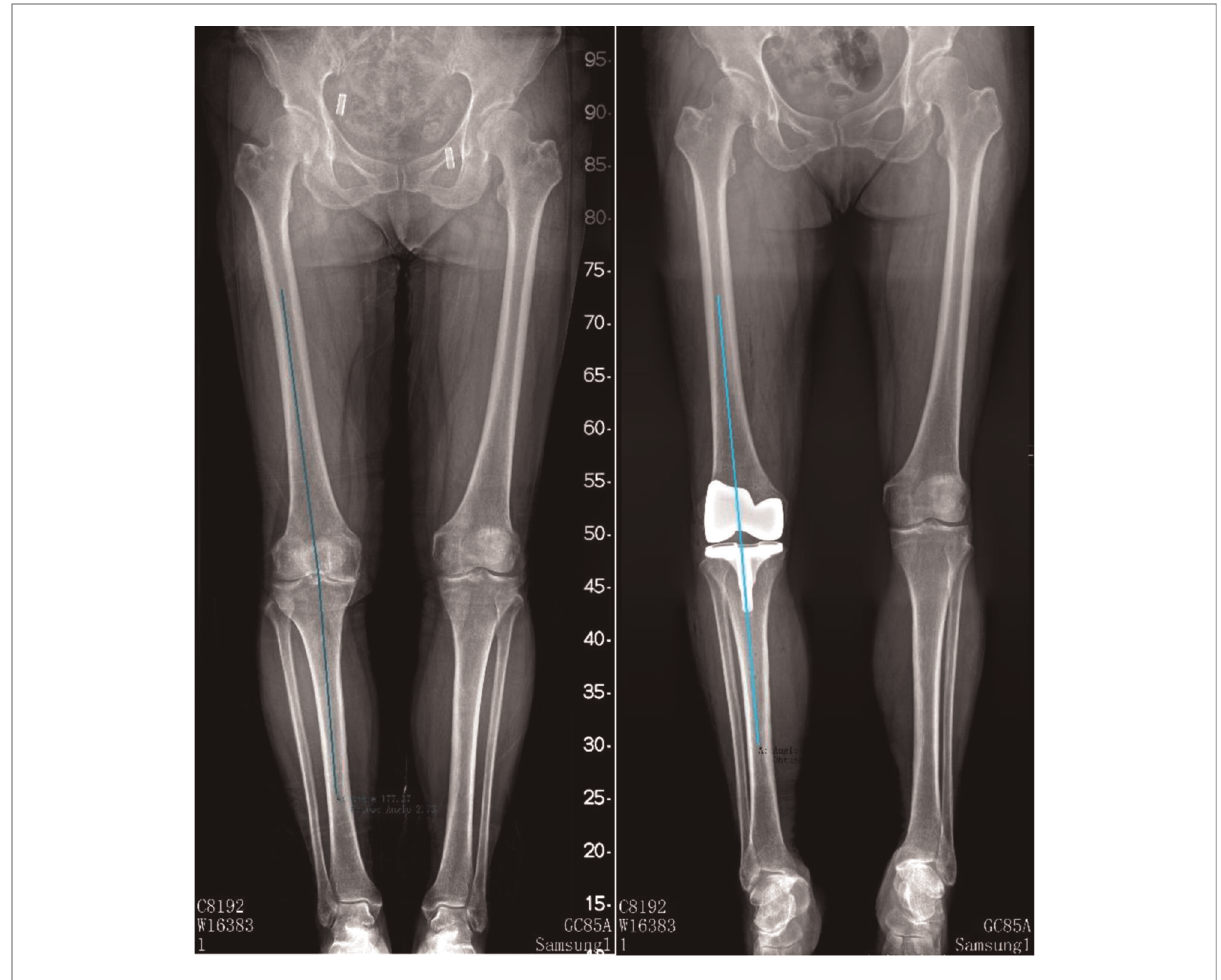
FIGURE 3 Pre-operation and post-operation FTA measurement